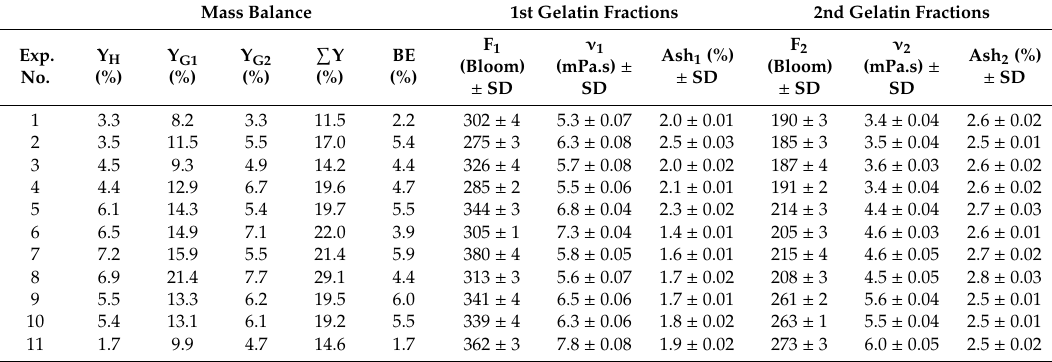
Table 2. Mass balance and the results of analysis of 1st and 2nd gelatin fractions prepared by biotechnological processing of laying hen collagen. Mass Balance 1st Gelatin Fractions 2nd Gelatin Fractions Exp.